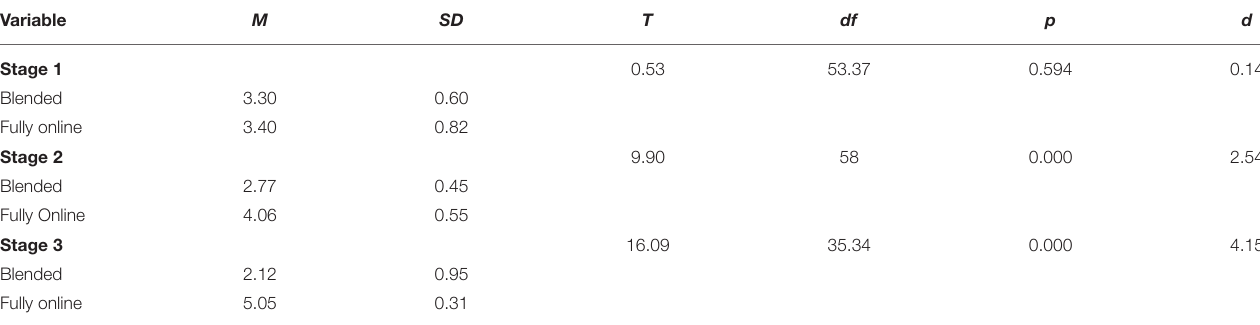
TABLE 1 | Comparison of blended learning and online learning on teachers’ burnout over the three stages ( n 1 = 30 and n 2 = 30). Variable